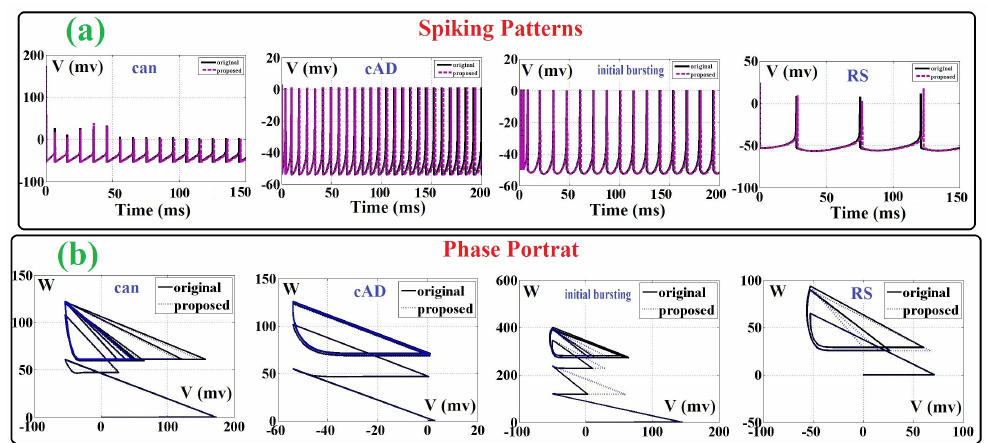
Figure 3. Comparison between the original and proposed ADEX in terms of spiking patterns and phase portrait. The proposed model is similar to the original ADEX model in two basic factors of the spiking patterns and phase